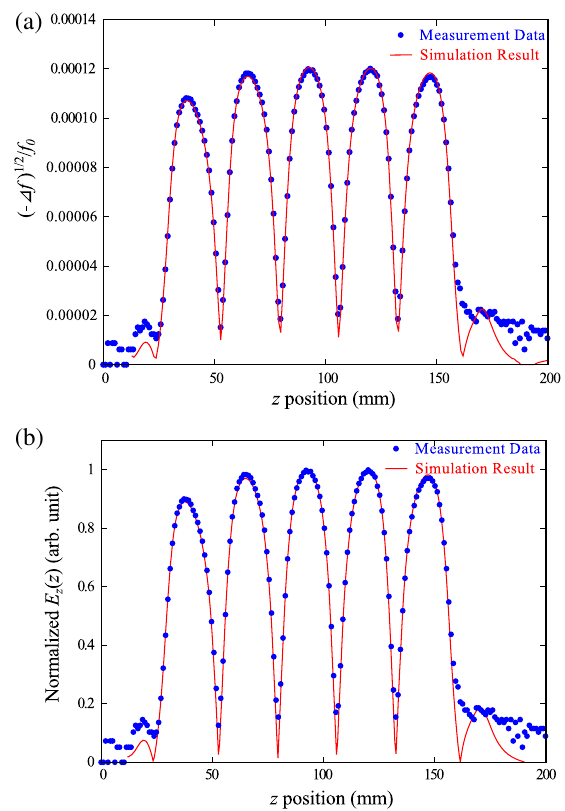
FIG. 13. (a) Comparison between the measured (blue dots) and the simulated (red line) values of between the simulated longitudinal field distribution of the accelerating mode along the beam axis for the DAA structure and the experimental result of the bead pull measurement. The experimental results (blue dots) show normalized which are scaled by using the maximum value of simulated results (red line) show normalized longitudinal electric field strength of the accelerating mode along the beam axis, which are scaled by using a maximum value of E